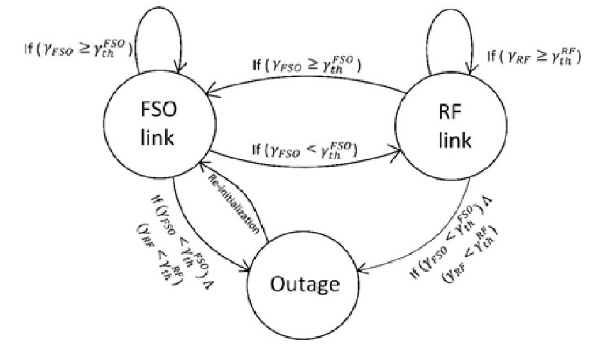
Figure 1. system block diagram. Figure 1. System block diagram.